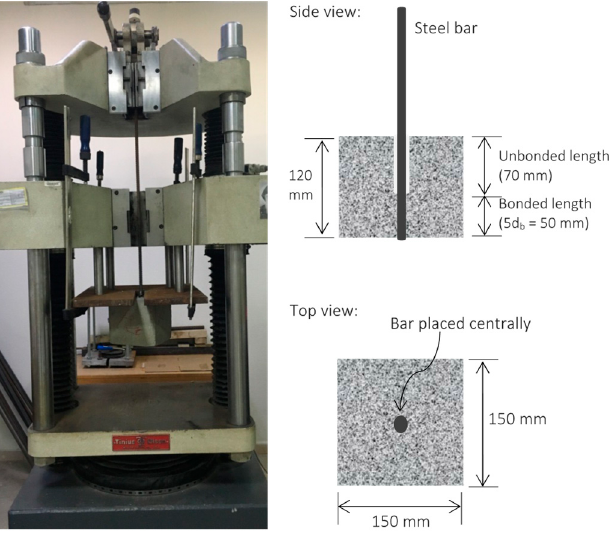
Figure 2. Photo and sketch for the set-up used for direct bond testing.